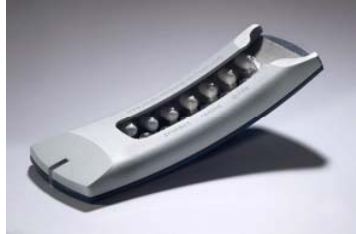
Figure 1. The Helping Hand TM (Bang &